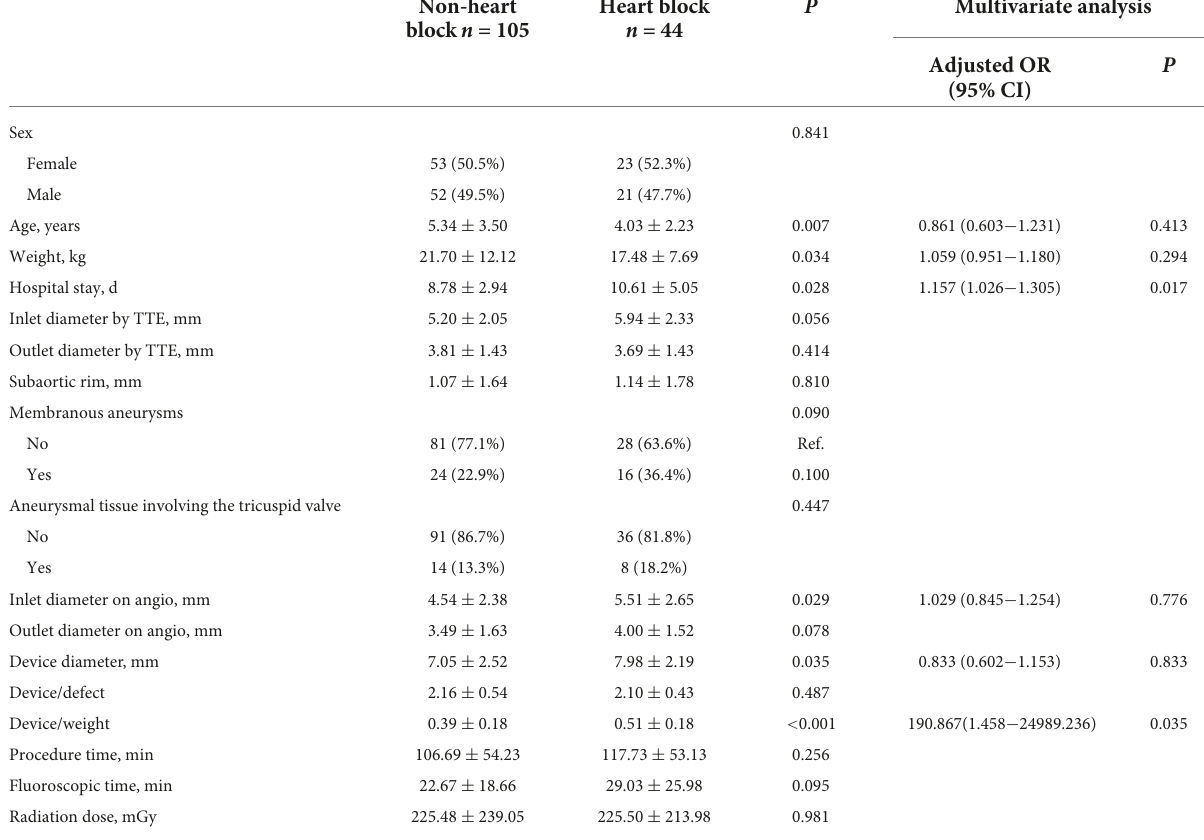
TABLE 7 Risk factors for occurrence of heart block in patients using eccentric